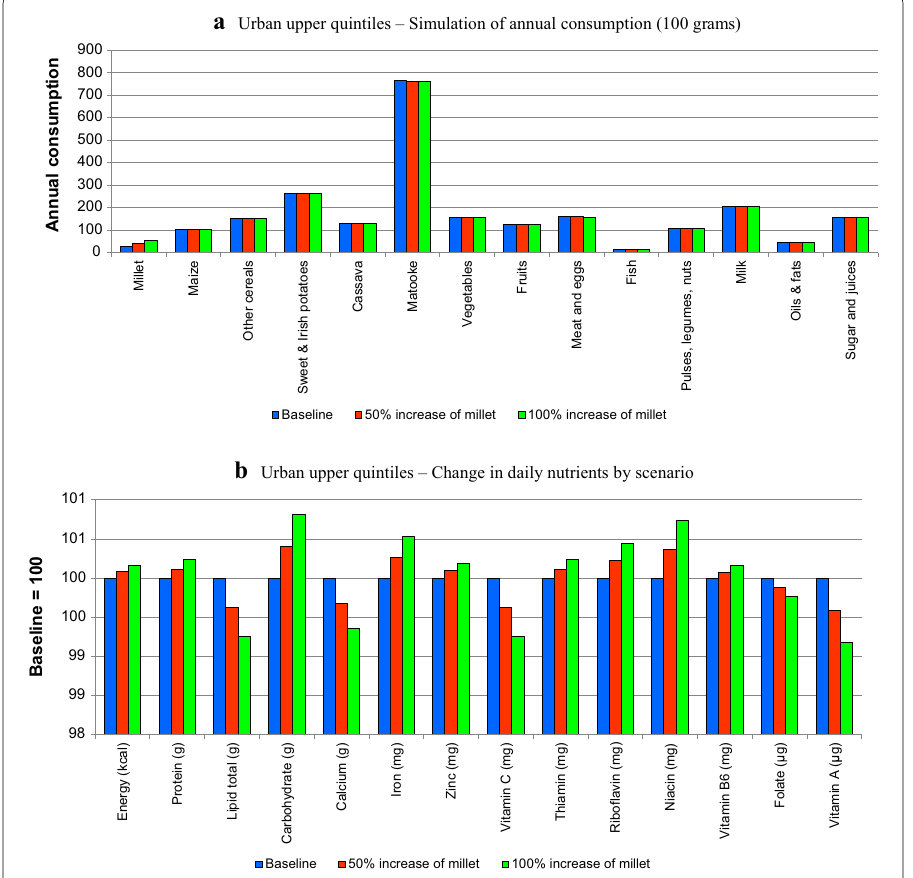
Fig. 5 a Urban upper quintiles—simulation of annual consumption (100 g). b Urban upper quintiles— change in daily nutrients by